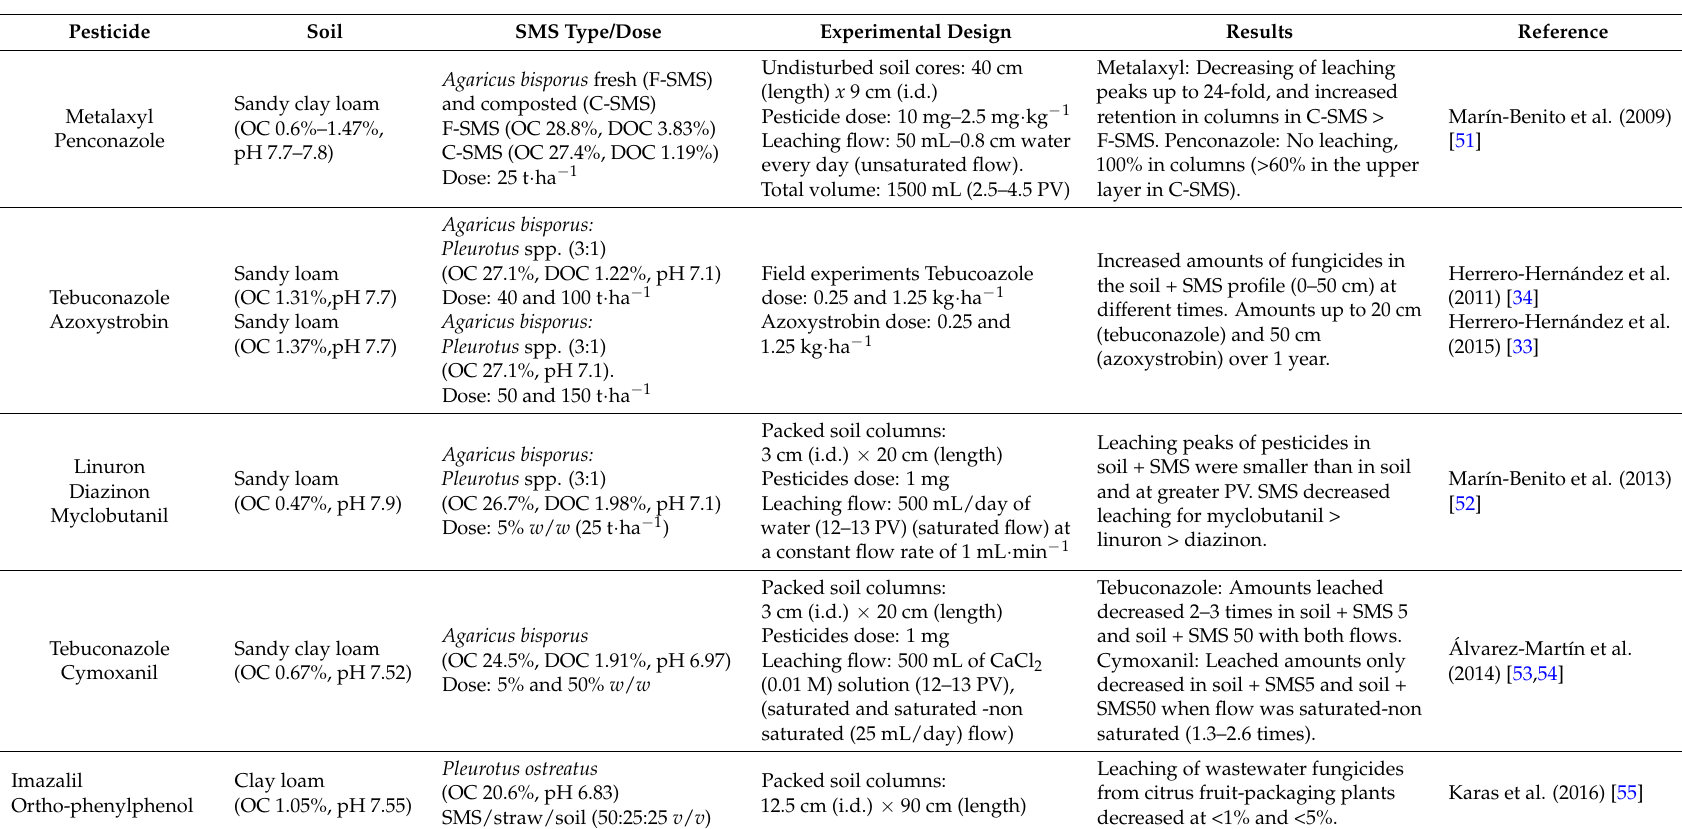
Table 4. Mobility of pesticides in SMS-amended